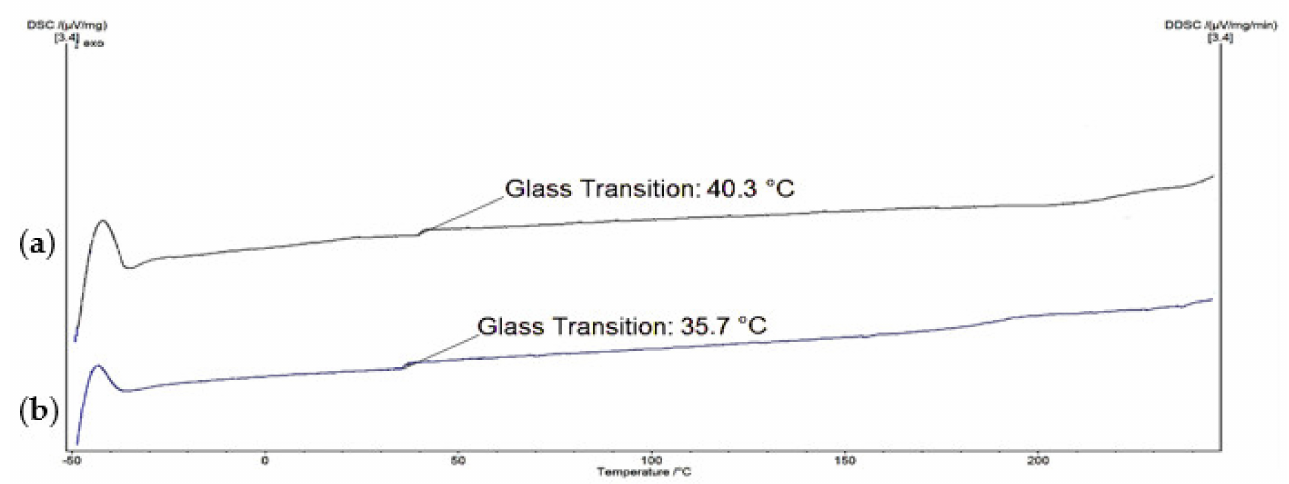
Figure 4. Typical DSC thermograms of alkylated ( a ) and native ( b ) pectin.